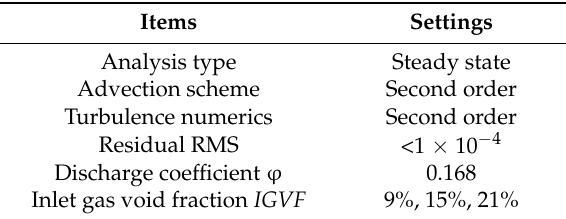
Table 5. Numerical solution strategy. RMS: root mean square.